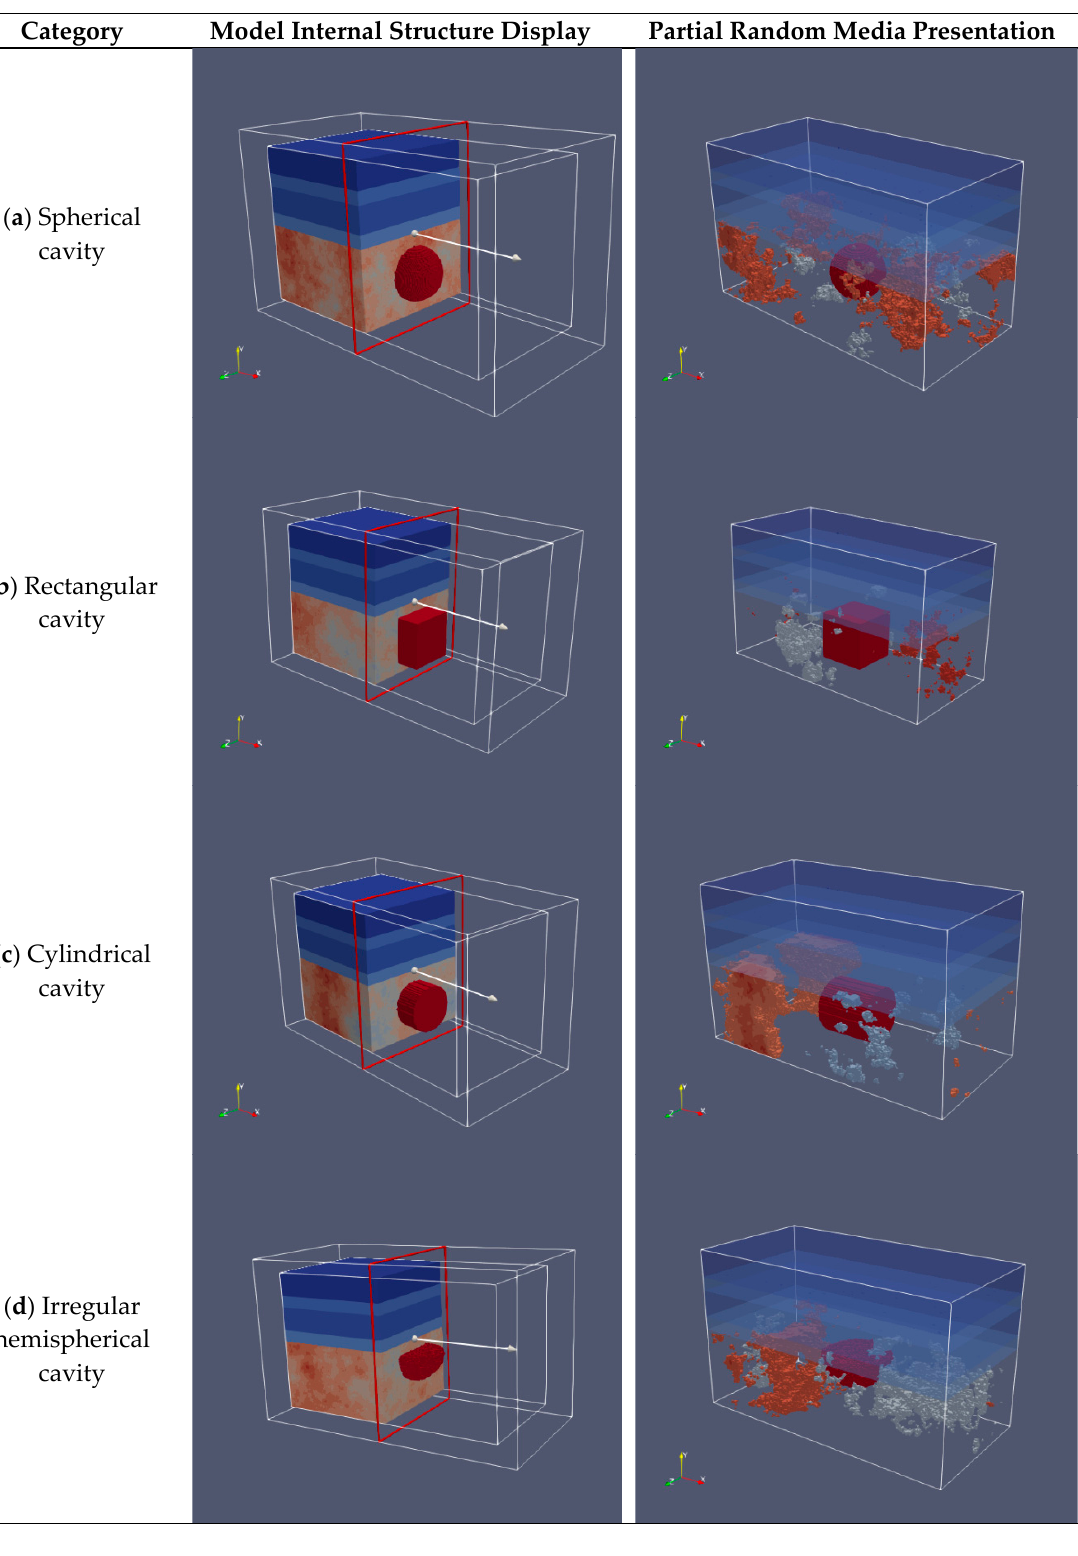
Figure 12. Display of simulation model from different perspectives (cavity in